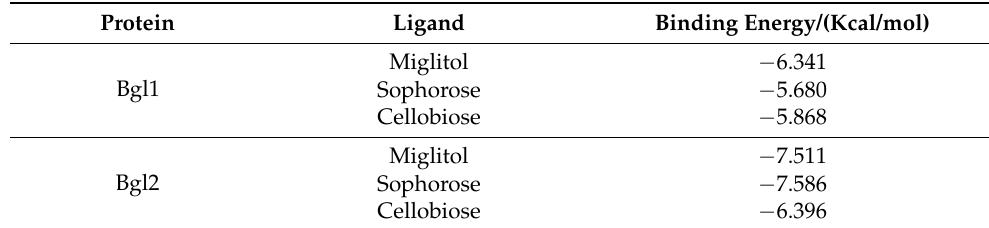
Table 1. Verification of the docking results for miglitol with β -glucosidase using the binding energy as the metric. Protein Ligand Binding Energy/(Kcal/mol)